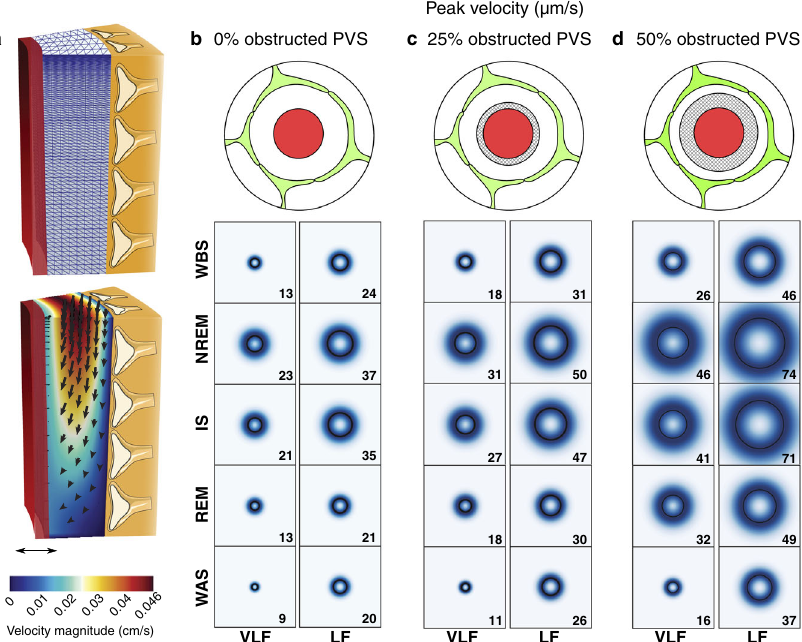
Fig. 3 | NREM/IS slow vasomotion increases predicted PVS fl uid velocity. a Illustration showing the model of the PVS (top), and representative vasomotion- driven CSF fl ow simulation (bottom). b – d Peak fl uid velocity in penetrating arter- iole PVS generated by VLF and LF oscillations during a sleep cycle as predicted by biomechanical modeling using three scenarios where we added a fi xed volume to the PVS obstructing fl ow corresponding to 0, 25, and 50% of our measured PVS in